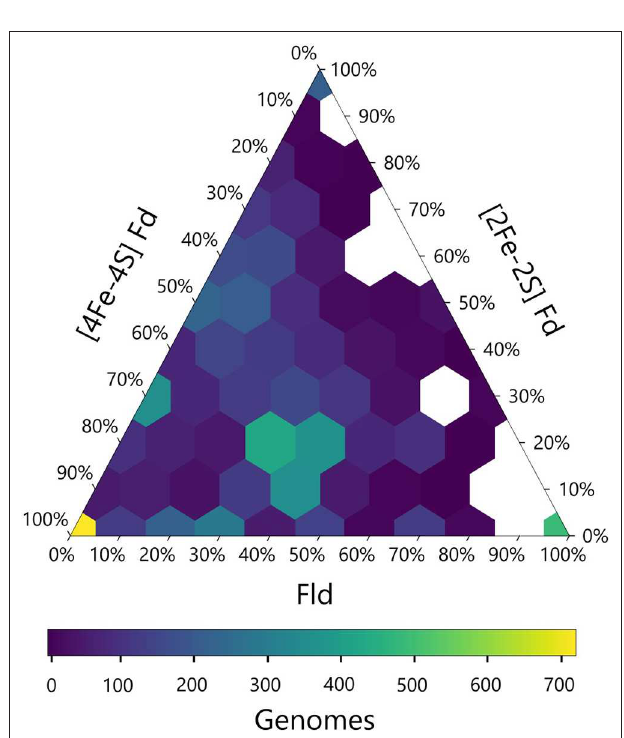
FIGURE 4 | Relative abundances of PEC specialist and generalists. The relative percentage of PEC gene counts for all three families are plotted with the density of organisms at each coordinate illustrated by a viridis color gradient. White hexagons represent combinations that were not